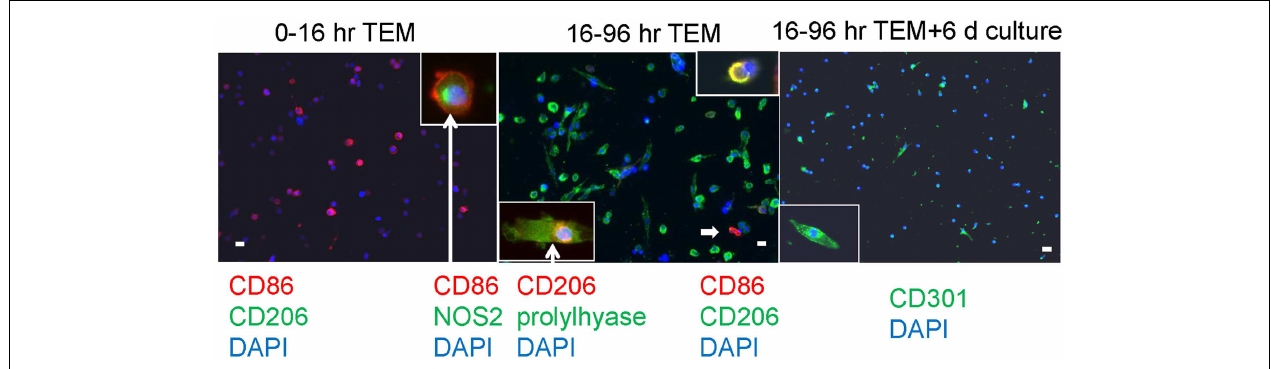
cell nuclei blue.The insets are cells at either higher magnification (CD301) or cells with external staining and an internal marker (CD86 plus NOS2 and CD206 plus prolylhydroxylase) with white arrows extending from the label. The white arrow within the center panel indicates a CD86 positive cell in the low magnification field, and the inset at top right shows a cell that is double positive for CD86 and CD206.White bars represent 20 µ